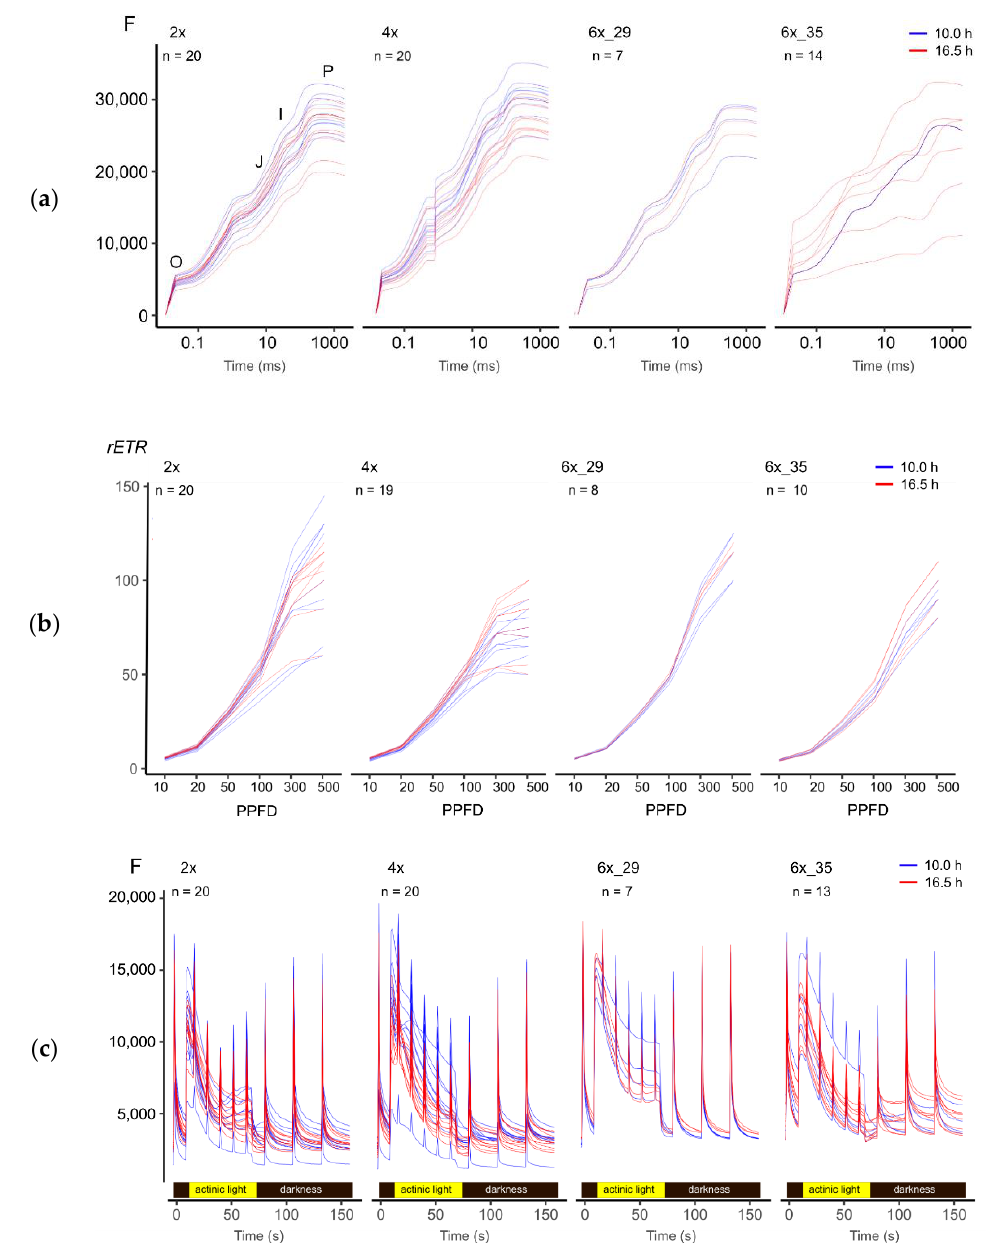
Figure 2. Visual overview of fluorescence experiments of R. auricomus cytotypes exposed to two different photoperiods: ( a ) fluorescent transient (OJIP) ( b ) light curve (LC) with increasing photosynthetic photon flux density (PPFD, µmol photons m − 1 s − 1 ), relative electron transport rate ( rETR ); ( c ) Kautsky curves